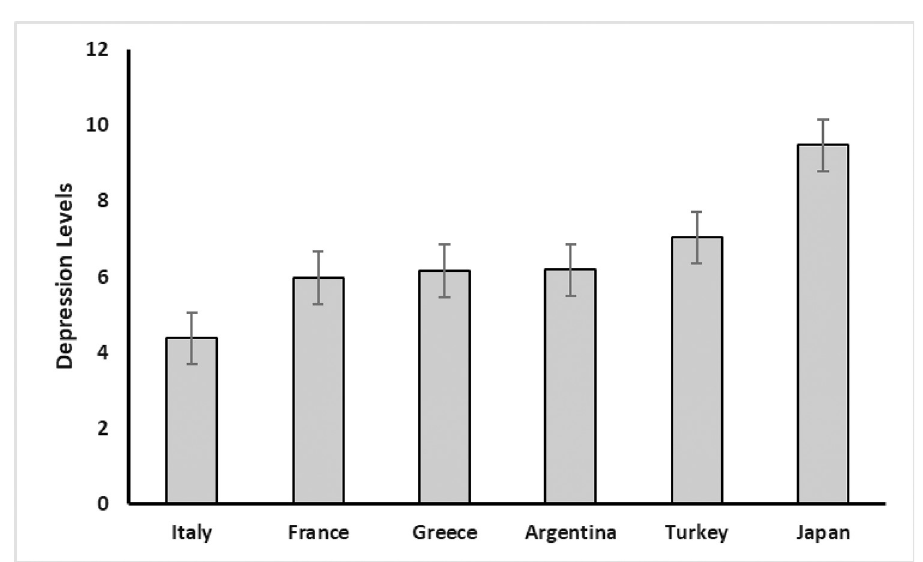
Fig 2. Average depression levels in the six studied countries. Whiskers represent the SE of the mean.